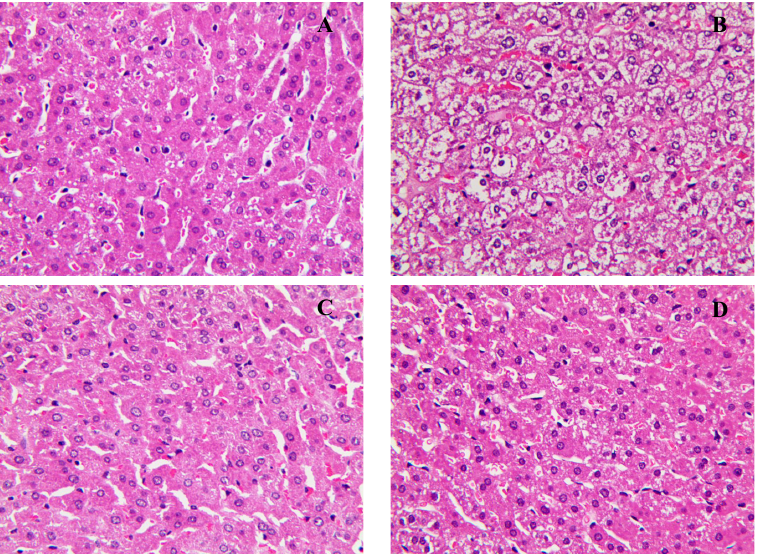
Figure 5. Effects of methanol extract of fermented green tea and spore suspension on fat granules in livers of hamsters for 2 consecutive weeks of intervention. ( A ): normal diet treated group (ND); ( B ): high-fat diet group (HFD): ( C ): high-fat diet with methanol extract of fermented green tea interven- tion group (MET); ( D ): high-fat diet with the spore intervention group (ST).